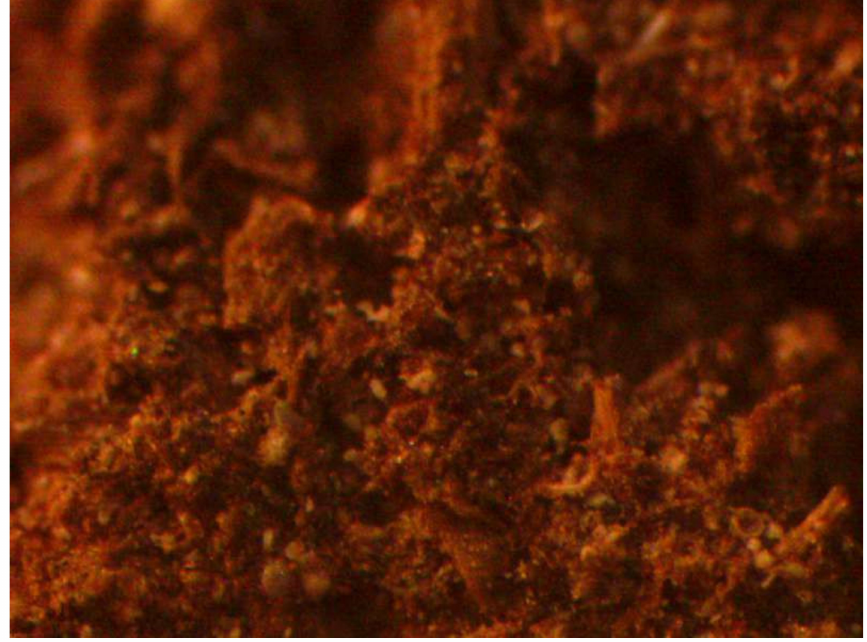
Figure 3. The surface of the peat–diatomite granular sorbent (Altami MET 1 optical microscope (Altami Ltd, Russia; it has been sourced from St. Petersburg, Russia); magnification ×